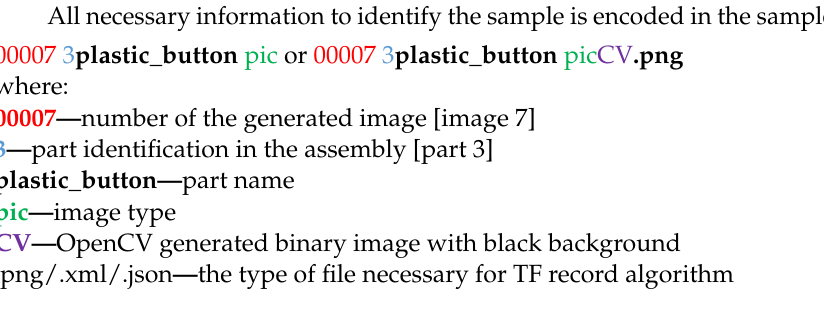
Figure 12. An example of the autogenerated training/tests set with XML bounding box annotation.